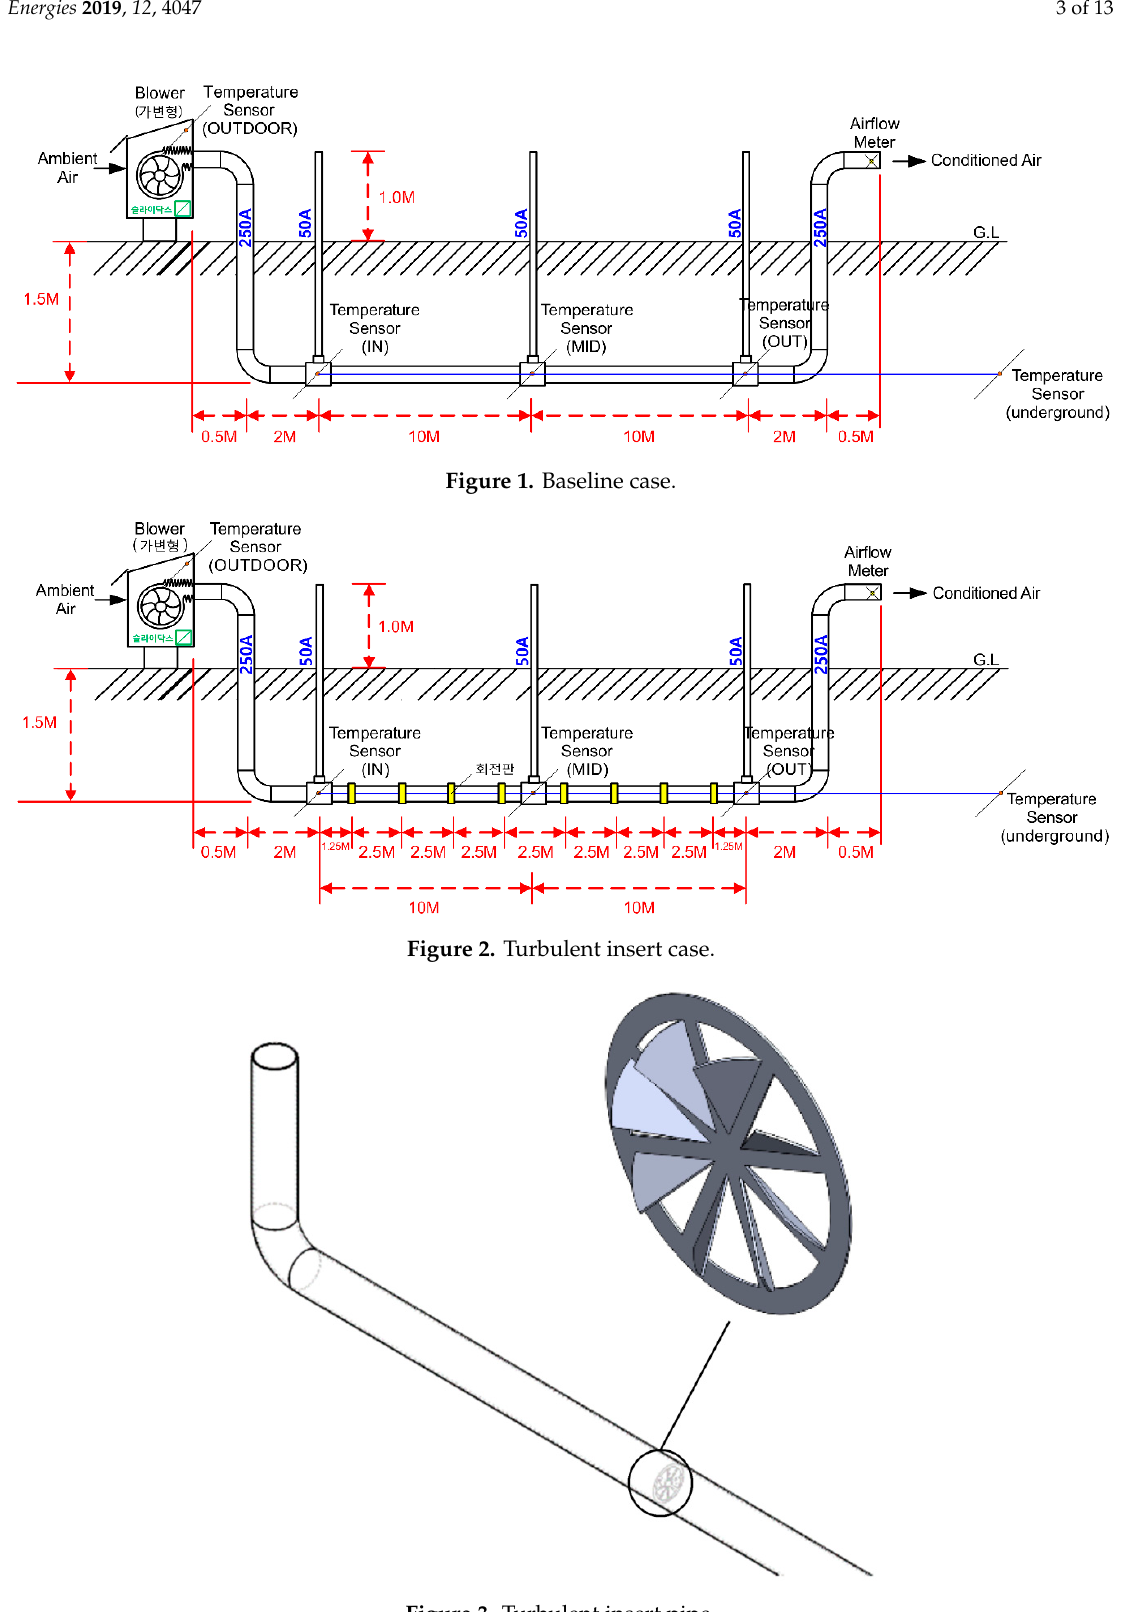
Figure 1. Baseline case.